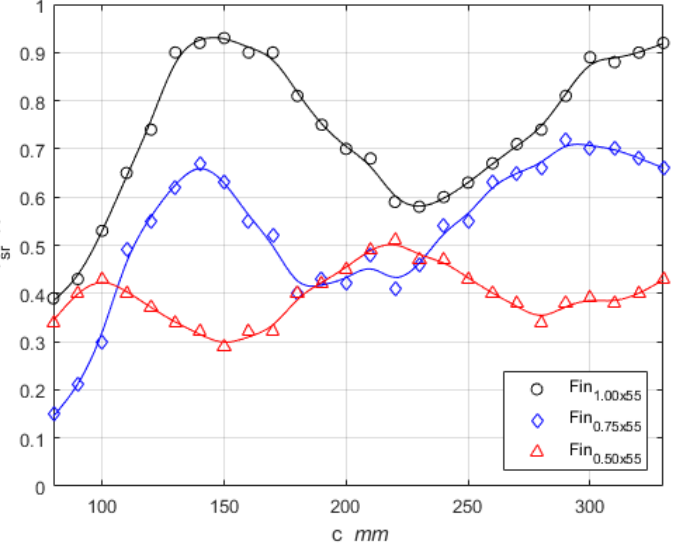
Figure 9. Thrust mean ( T sr ) as a function of the fins length for fin widths equal to 55 mm, and different fin